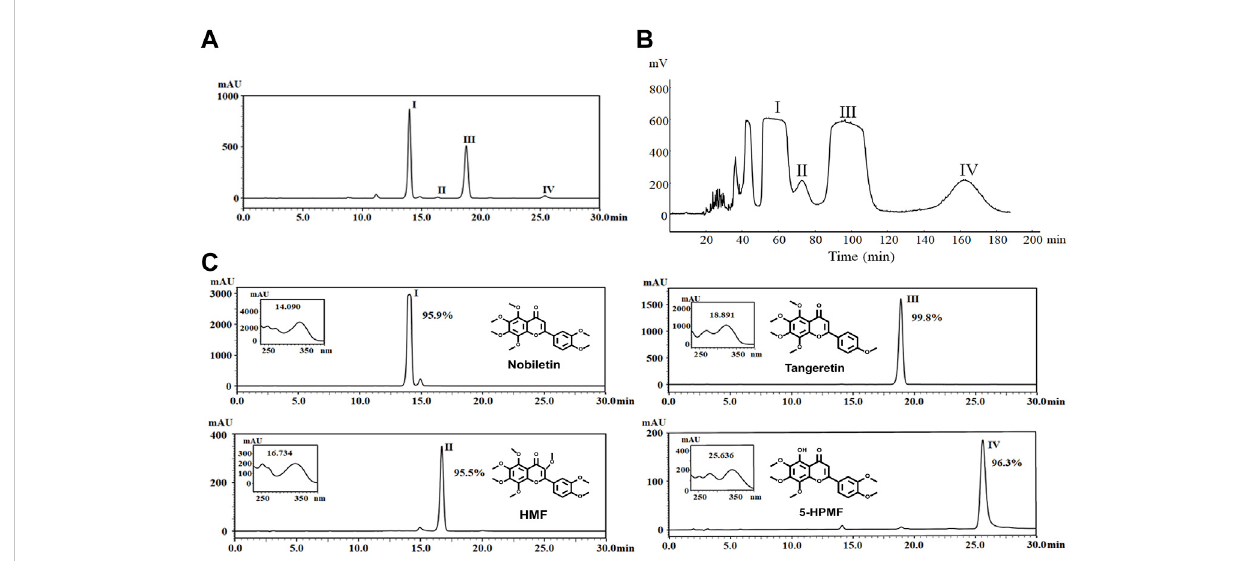
FIGURE 1 (A) HPLC chromatogram of nobiletin (I), HMF (II), tangeretin (III), and 5-HPMF (IV) puri fi ed from a PE deposit of CRCP at 330 nm. (B) Chromatogram of HSCCC separation for components (I – IV) at 330 nm and a fl ow rate of 2 mL · min – 1 . Fractions (I – Ⅳ ) were collected from the ef fl uent. (C) Identi fi cation and purity analysis of fractions (I – IV) by ESI-MS, 1 H-NMR, 13 C-NMR, and